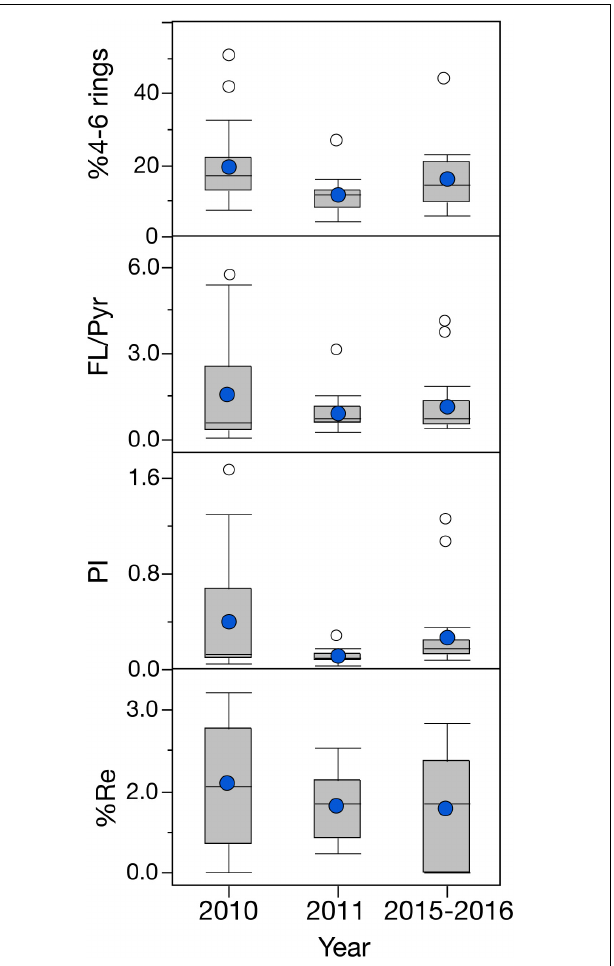
FIGURE 7 | Temporal variation of PAH ratios in the mantle tissue of deep-sea cephalopods collected in the northern Gulf of Mexico. Sampling years: pre-spill: 2010, post-spill: 2011, and long-term: 2015–2016. Graph shows shaded boxes as the interquartile ranges, with horizontal lines indicating median values and whiskers representing 10th and 90th percentile. Blue circles denote mean values, and white circles denote outliers. Data are shown as mean ±